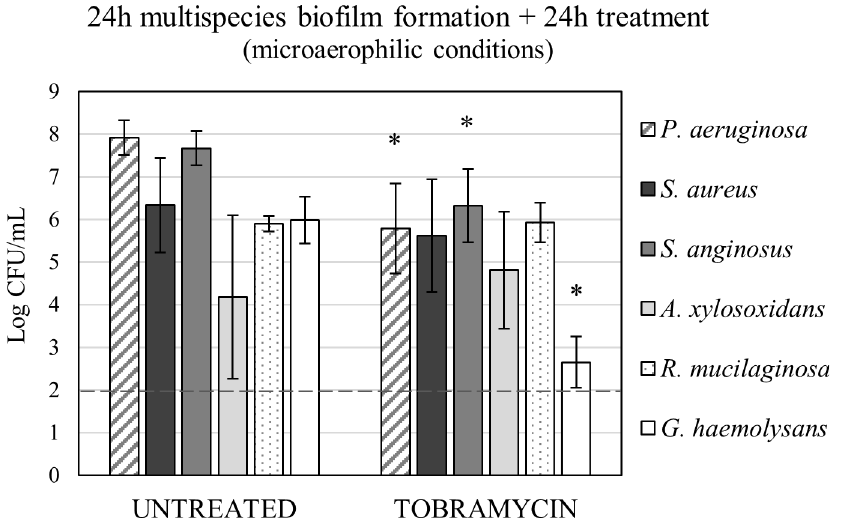
Fig 4. Proof of concept: Quantification of multispecies biofilms. A multispecies biofilm of the six bacterial species was grown for 24 hours and subsequently incubatedwith fresh medium as an untreatedcontrol or treated with 100 μ g/mL tobramycinin medium for an additional 24 hours in microaerophilic conditions. Graphs show mean recovery and standard deviations. The detection limit of 10 2 CFU/mL is representedby a dashed line. * p < 0.05, n (cid:21)